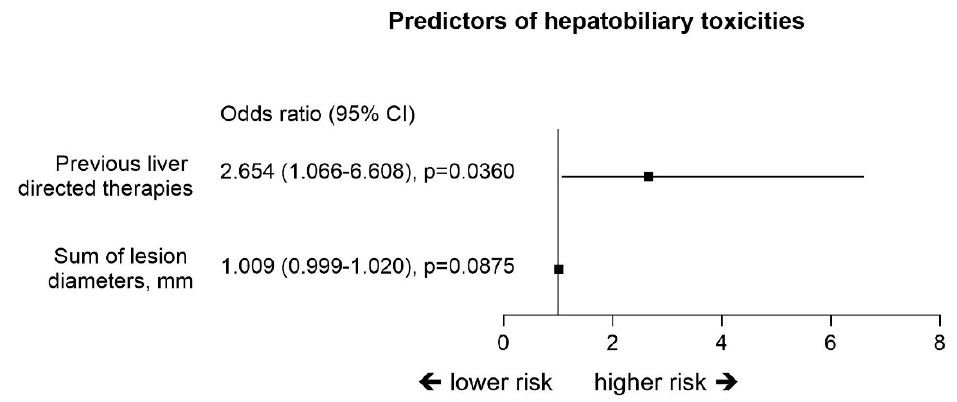
Figure 1. Multivariate analysis for the prediction of hepatobiliary toxicities (Logistic regression models). There was no significant di ff erence in progression-free survival (PFS) (median; 95% CI): 15.2 (10.3; 17.0) vs. 13.4 (9.9; 15.6) p = 0.44), time to TACE untreatable progression (TTUP) (median: 16.5